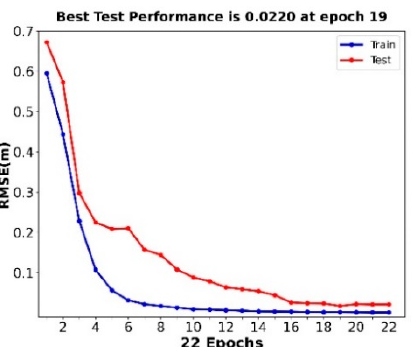
Figure 3. The outcome of the grid search strategy: ( a ) the RMSE variation with the number of neurons; ( b ) the RMSE variation with the number of hidden layers. Error bars have been included for each RMSE value based upon the standard deviation.